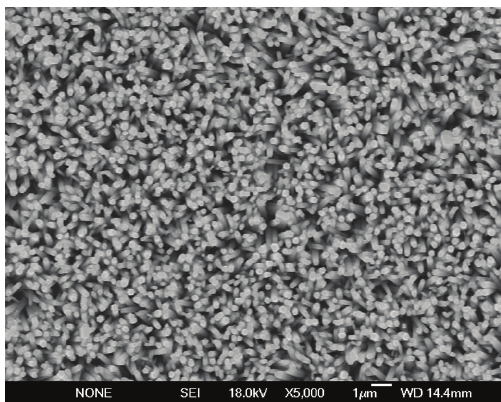
Figure 1: A typical FESEM image of ZnO nanorods grown on the gold coated glass substrate using hydrothermal growth